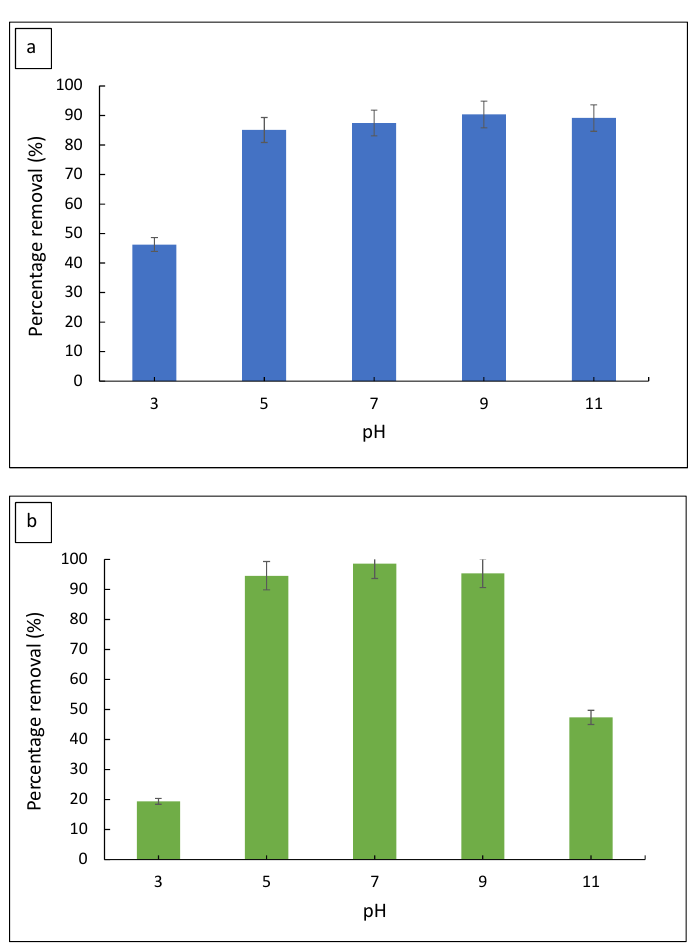
Figure 5. The effect of the initial dye solution pH on the percentage removal of ( a ) MB and ( b ) MG.